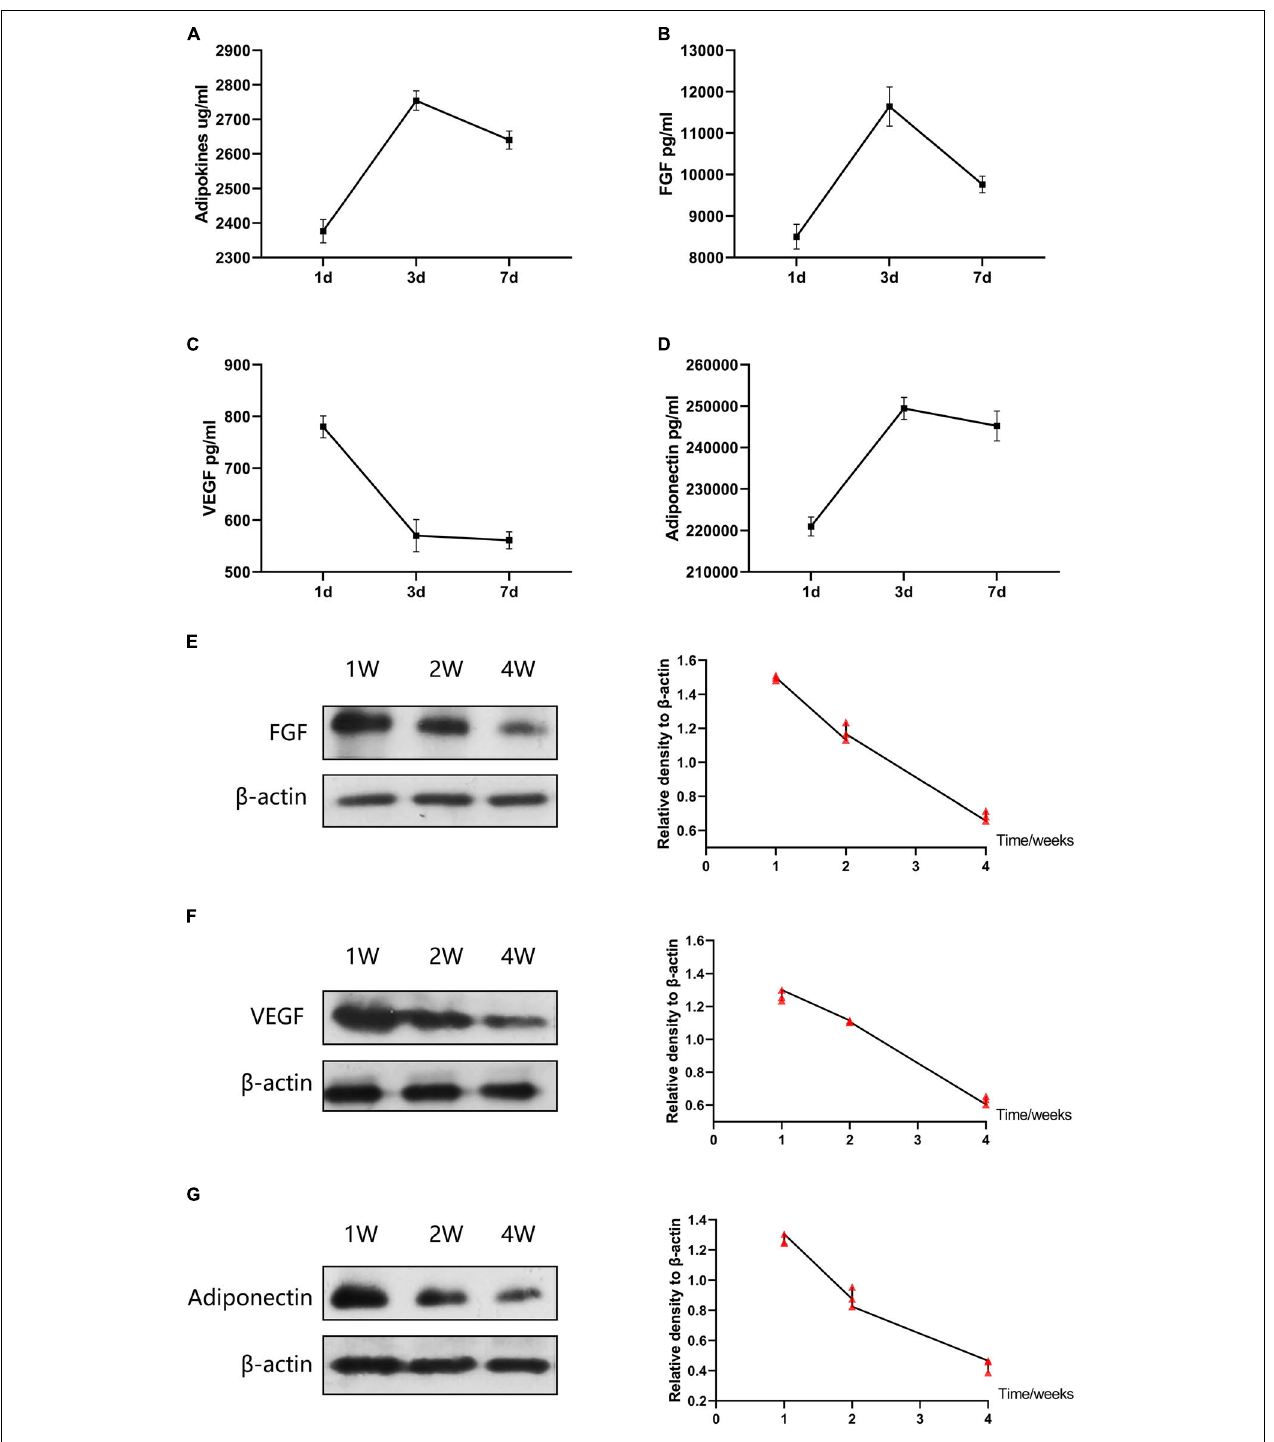
FIGURE 7 | Adipokines release of ACF in vitro and in vivo . (A–D) Concentrations of total adipokines, FGF, VEGF, and adiponectin released from ACF on days 1, 3, and 7 in vitro . The experiment was independently repeated three times. (E–G) Western blot of FGF, VEGF, and adiponectin in skin samples at week 1, 2, and 4. The contents of FGF, VEGF, and adiponectin in skin samples were gradually decreasing over time in the 4 weeks. P (FGF at week 1–2) = 5.273E-04, F (FGF at week 1–2) = 0.143; P (FGF at week 1–4) = 1.706E-06, F (FGF at week 1–4) = 0.399; P (FGF at week 2–4) = 1.404E-04, F (FGF at week 2–4) = 0.472. P (VEGF at week 1–2) = 1.521E-03, F (VEGF at week 1–2) = 0.062; P (VEGF at week 1–4) = 1.346E-05, F (VEGF at week 1–4) = 0.701; P (VEGF at week 2–4) = 5.723E-06, F (VEGF at week 2–4) = 0.111. P (adiponectin at week 1–2) = 8.120E-04, F (adiponectin at week 1–2) = 0.417; P (adiponectin at week 1–4) = 1.224E-05, F (adiponectin at week 1–4) = 0.742; P (adiponectin at week 2–4) = 5.626E-04, F (adiponectin at week 2–4) = 0.617. N =